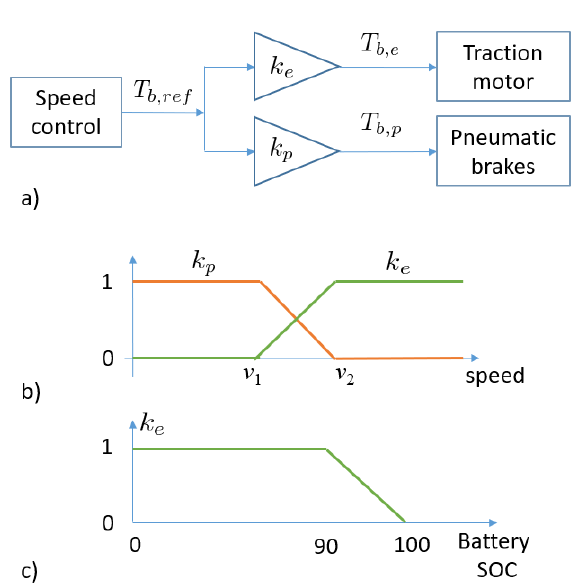
Figure 4. Braking strategy that combines electric and pneumatic braking scheme ( a ). Distribution pneumatic and electric coefficients as function of vehicle speed ( b ). Electric distribution coefficient as function of battery SOC ( c ).